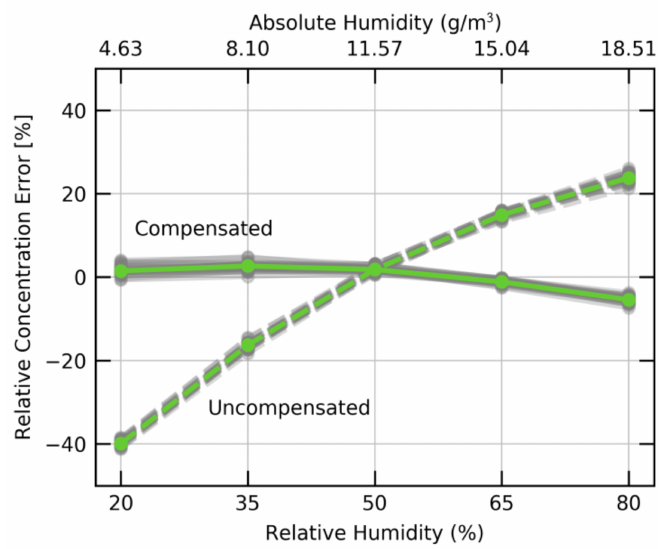
Figure 8. Relative error of the ethanol concentration (dotted line) at 10 ppm ethanol as function of humidity at 25 ◦ C. Data of 32 SGP30 sensors (grey) and the median (green) is plotted. Additionally, the signal after on-chip correction using an external humidity signal is shown (solid